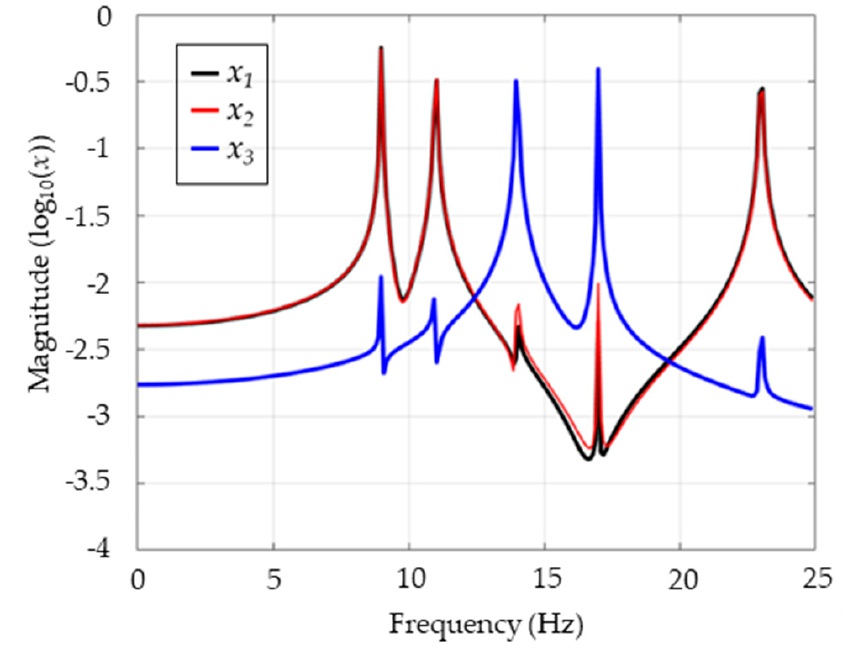
Figure 4. Frequency response of x 1 , x 2 , and x 3